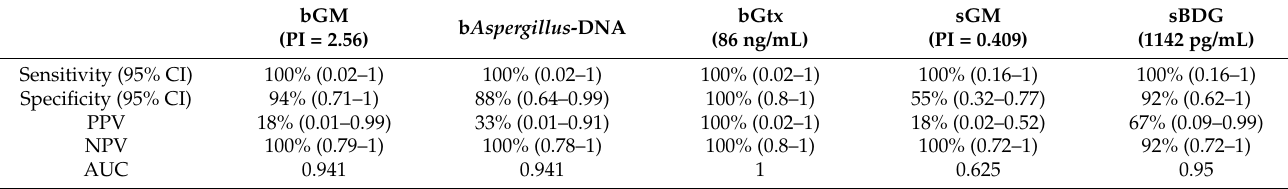
Table 2. Aspergillus biomarkers in equine BALF and serum.